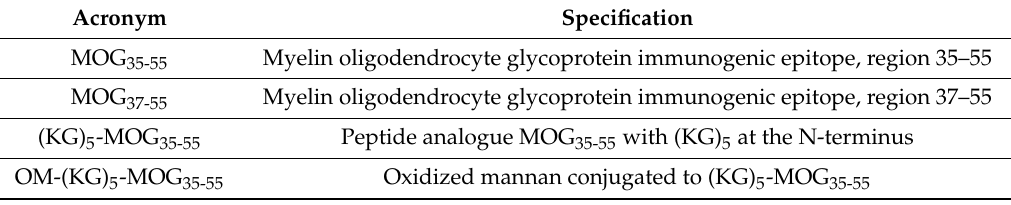
Table 1. Peptides and conjugates used in this